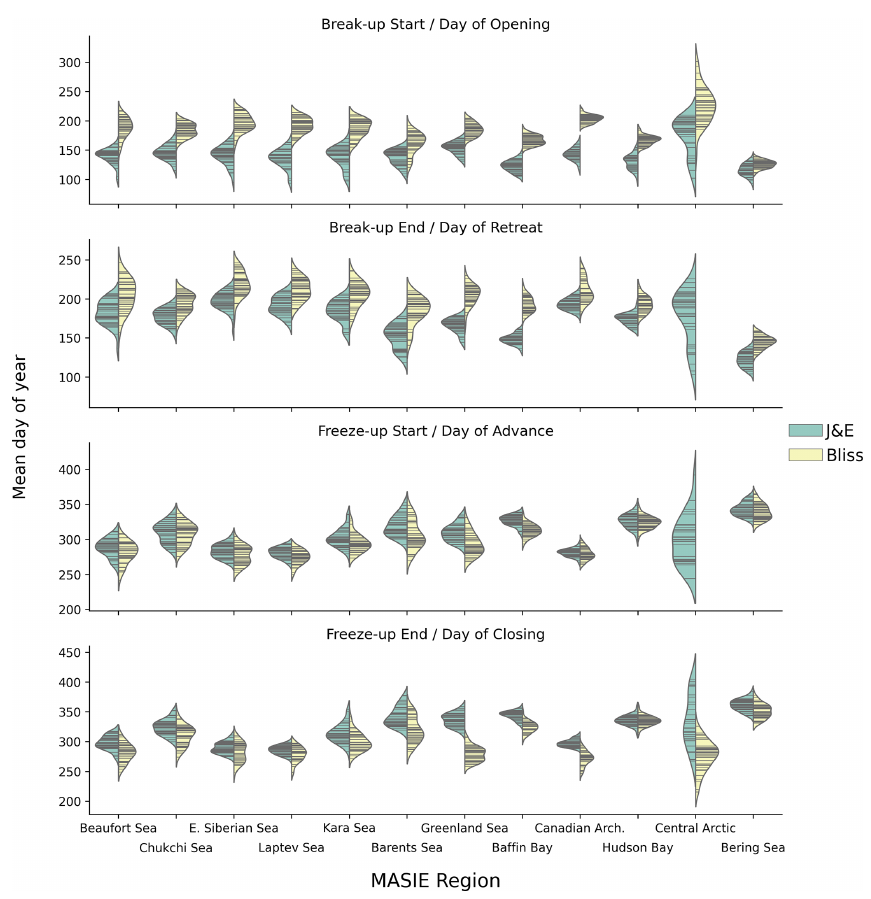
Figure 5. “Violin” plots of the Julian dates of the breakup and freeze-up metrics used in this study based on Johnson and Eicken (2016) (green shading) and the corresponding dates of ice opening, retreat, advance, and closing as defined by Bliss et al. (2019) (yellow shading). A violin plot shows a distribution by widening the horizontal lines in the ranges (of day of the year, in this case) having the highest concentration of values. The thin black lines represent the observations themselves; the black strips are clusters of lines representing groups of similar values in the distribution. The violin plots provide no information about the temporal sequence of the values.